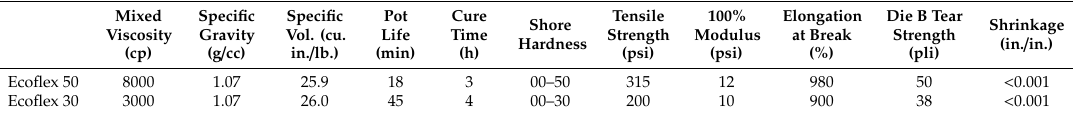
Table 1. Ecoflex sample technical data (from safety data sheet provided by Smooth-On Inc).